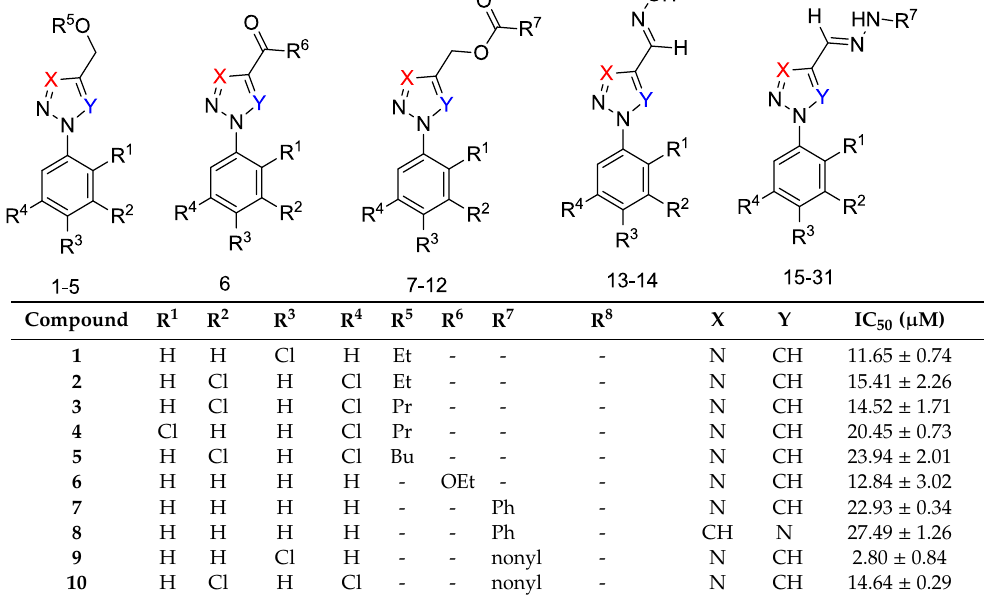
Table 1. Results obtained with the screening of the 1 H -1,2,3-triazoles library in P. falciparum (3D7); molecular structure of each compound; IC 50 values with the standard error of the mean.